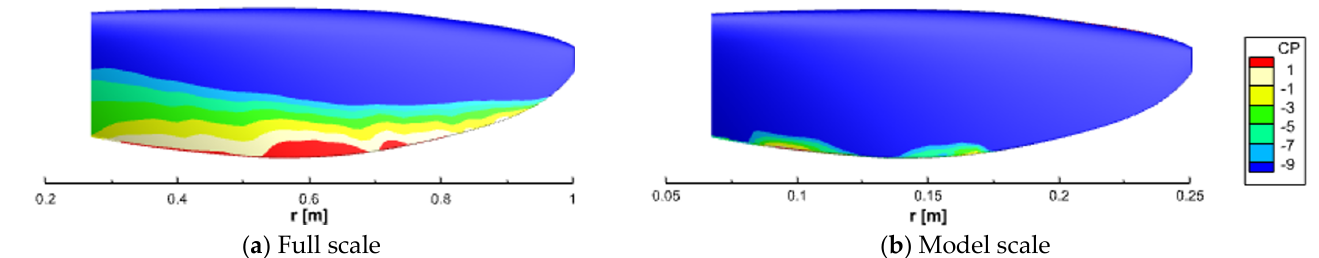
Figure 15. Comparison of the blade surface pressure distribution (suction side) at J = 0.32; pitch angle = 34°.